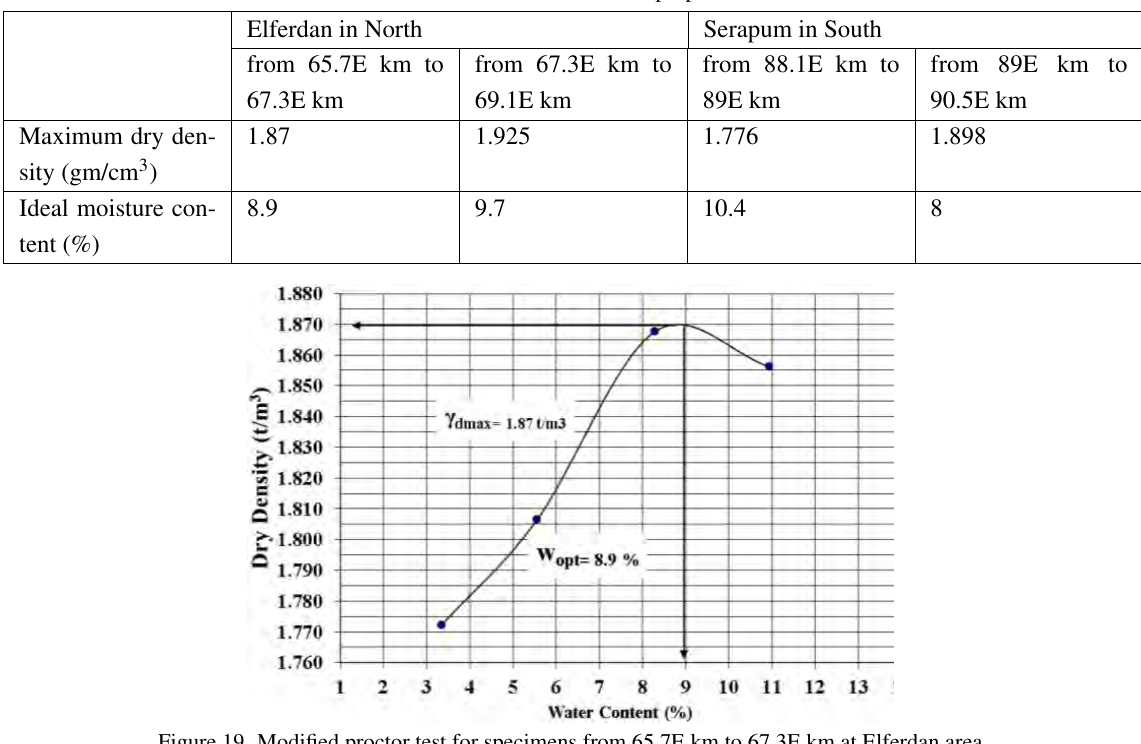
Figure 19. Modified proctor test for specimens from 65.7E km to 67.3E km at Elferdan area